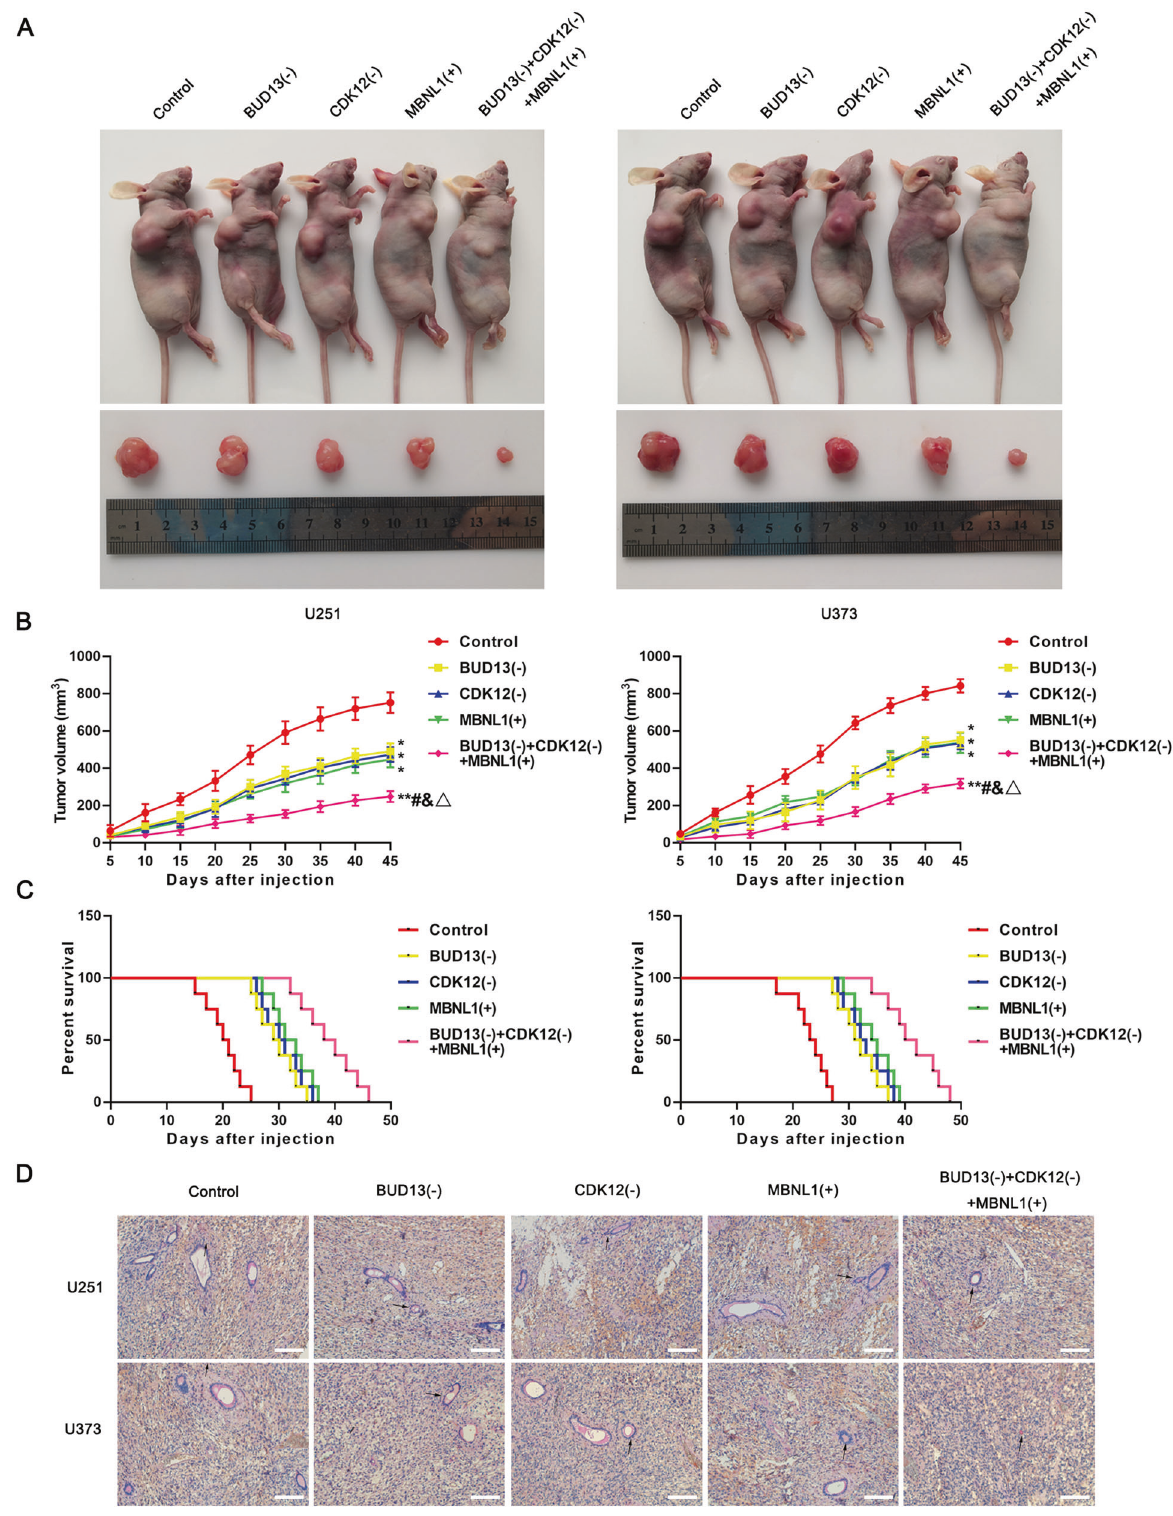
Fig. 6 Knockdown of BUD13 and CDK12 combined with overexpression of MBNL1 inhibited the growth of GBM and prolonged the survival period of nude mice. A Subcutaneously xenografted nude mice injected with differently treated cells are shown (above). Representative tumors from each group are shown (below). B Tumor growth curve ( n = 8). Tumor size was recorded every 5 days and tumors were removed after day 45. * P < 0.05, ** P < 0.01, compared with the Control group; # P < 0.05, compared with BUD13(-) group; & P < 0.05, compared with CDK12(-) group; Δ P < 0.05, compared with MBNL1( + ) group. C Survival curve of subcutaneously transplanted tumor in nude mice ( n = 8). D CD34-PAS staining was used to detect tube-forming ability in nude mice tumors. Scale bar: 50 μ m. Arrows indicate VM